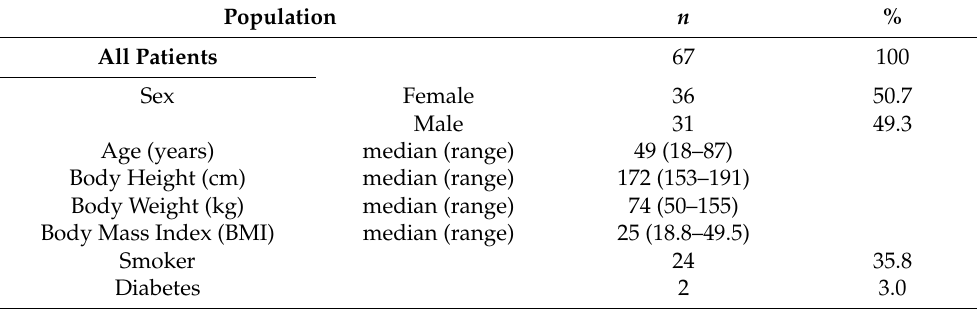
Table 1. Study population.